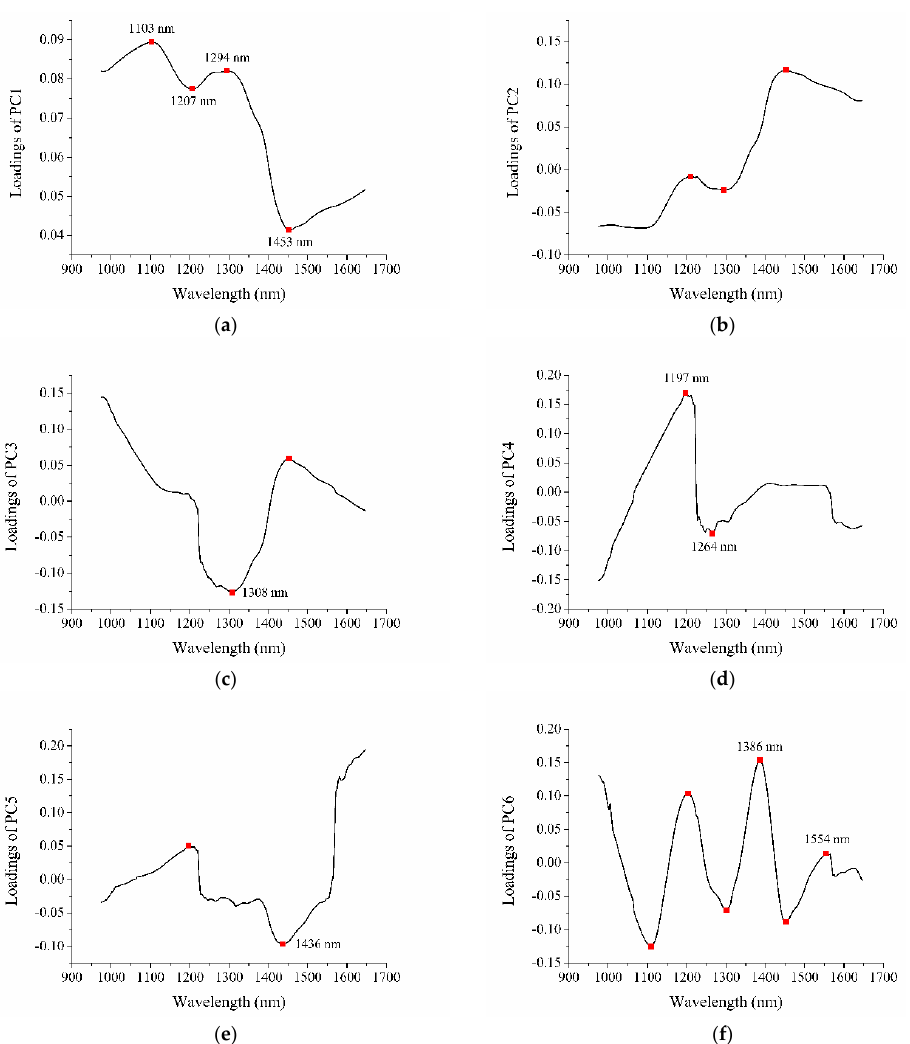
Figure 3. Loadings of the first six PCs for: ( a ) PC1; ( b ) PC2; ( c ) PC3; ( d ) PC4; ( e ) PC5; and ( f )